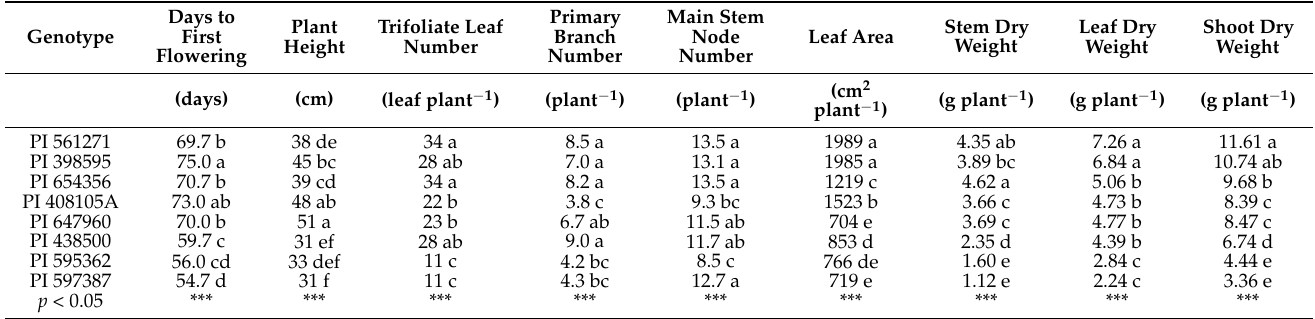
Table 1. Shoot traits of eight soybean genotypes grown in 1.5 m-deep rhizoboxes. Values are the mean of three replicates (two plants per rhizobox). Means followed by different letters in the same column differ significantly at p < 0.05 using Tukey’s honest significance difference (HSD). *** indicates significant difference among genotypes at p < 0.001.